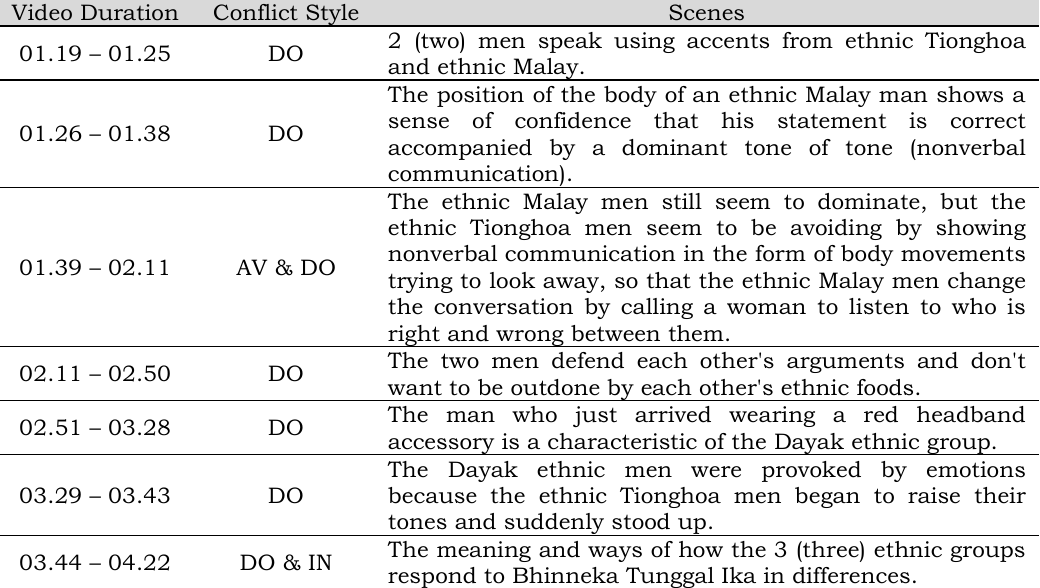
Table 1. Meaning of conflict style in video as Signal Video